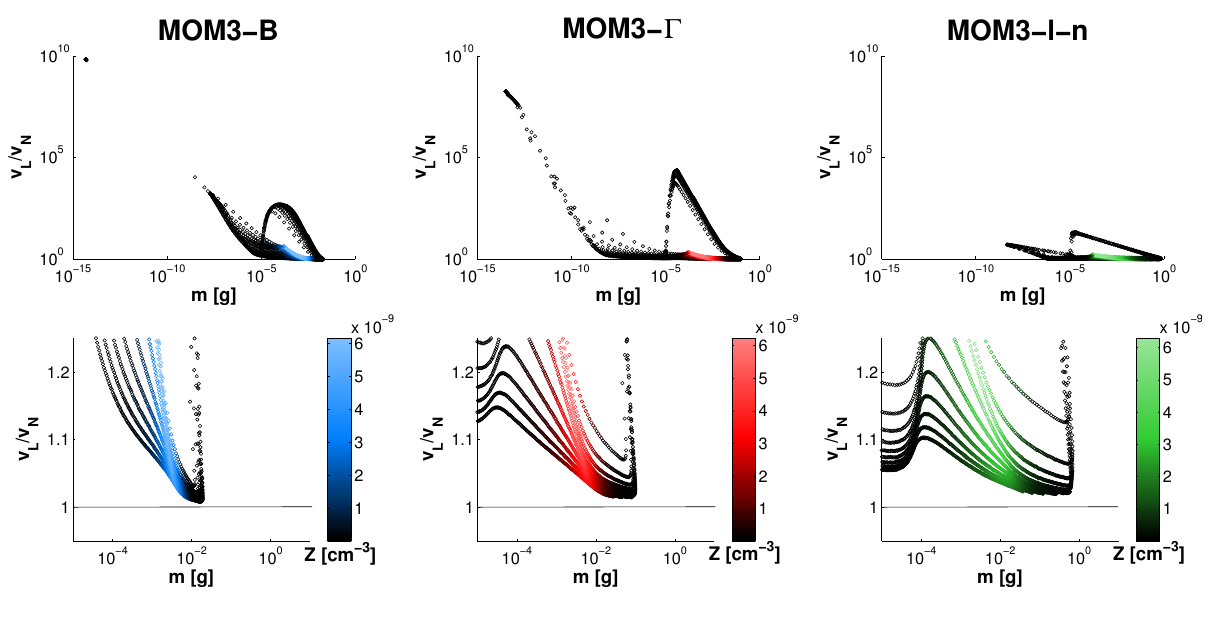
Figure 10. Ratio of the mean fall speeds of L and N against mean mass m for the three distribution functions. ( Top ) Overview in log-log representation. ( Bottom ) Zoom-in for the log-lin representation. See the text for